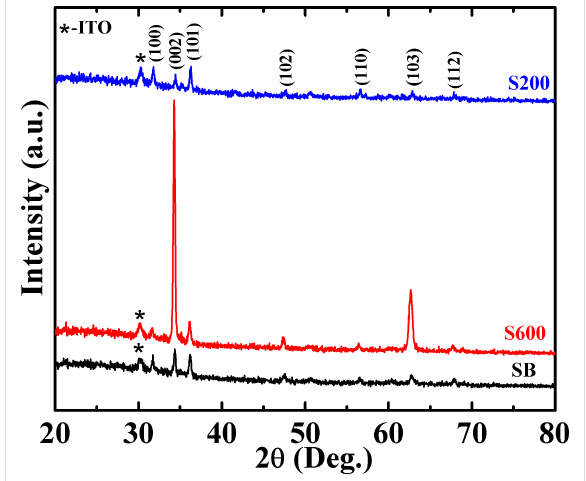
Figure 3: X-ray diffraction spectra of ZnO NCs for SB (on bare ITO), S600 (on patterned ITO with pore size ≈ 600 nm), and S200 (on patterned ITO with pore size ≈ 200